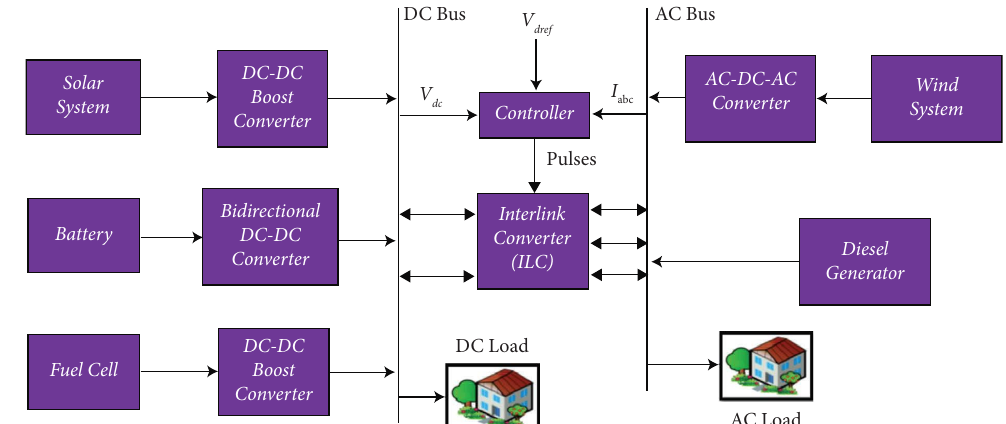
Figure 1: Hybrid AC/DC MG system.